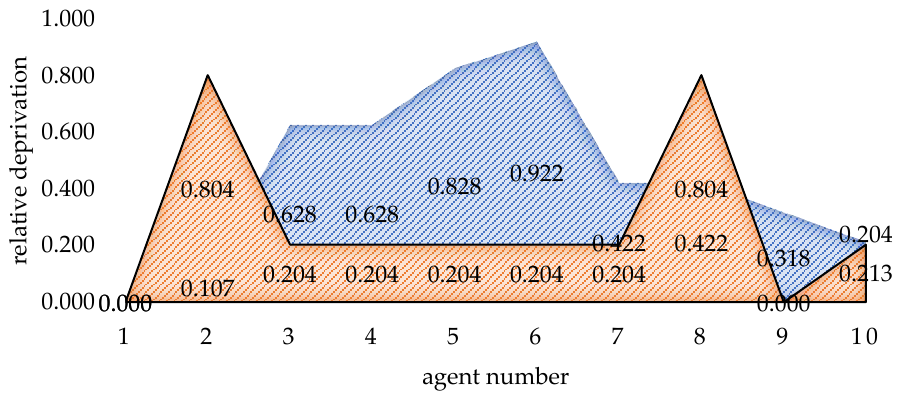
Figure 11. Change in agent's relative deprivation after adjusting parameters .